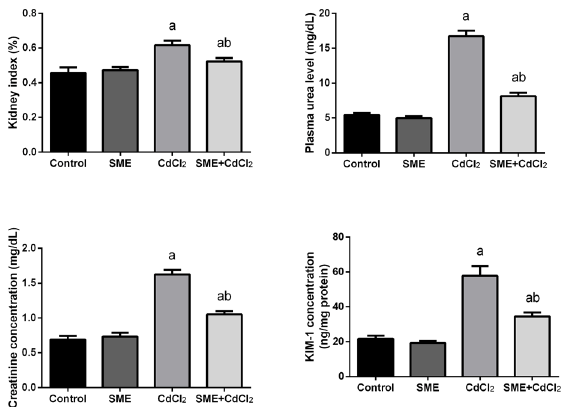
Figure 1. The kidney index, and serum level of kidney function markers (urea and creatinine) and kidney injury molecule-1 in adult male rats treated with CdCl (3.5 mg/kg) and/or SME (100 mg/kg). Values are 2 expressed as the mean ± SD (n = 10). a p <0.05 vs. the control group; b p <0.05 vs. the CdCl -treated 2